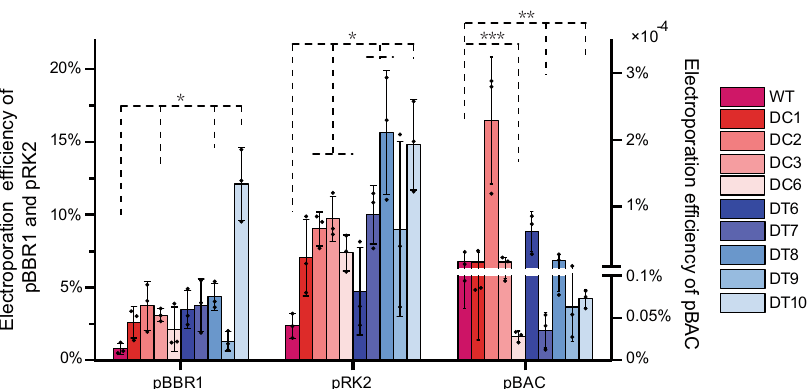
Fig. 4 Electroporation ef fi ciency comparison. The absolute electroporation ef fi ciency of the WT and the DT6 to DT10 mutants were calculated with two small multicopy plasmids pBBR1 and pRK2 replicon (the left Y axis) and a 99 kb pBAC plasmid carrying an oriT-tnpA-IR transposable element and a rhizoxin BGC (the right Y axis). Data are presented as mean values± SD. n = 3 biologically independent samples. P values were determined by two-tailed